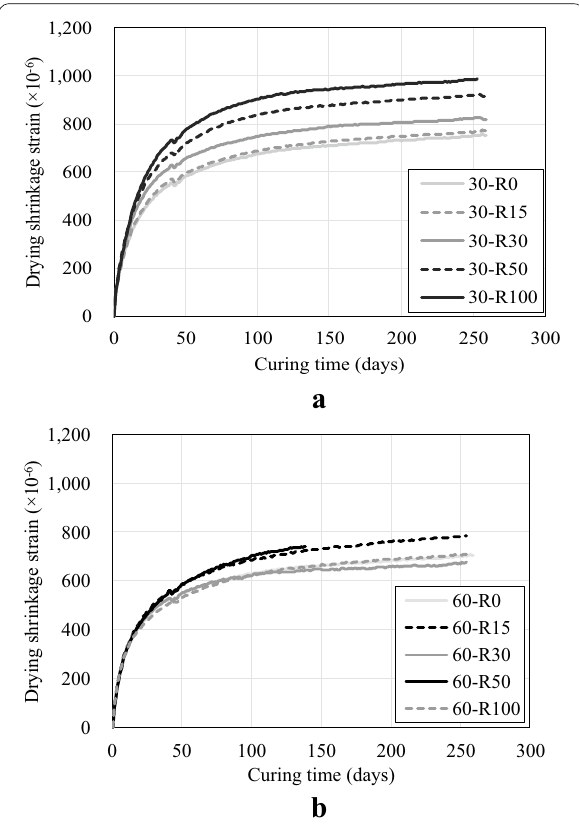
Fig. 5 Comparison of the compressive strength between the present study and previous experimental results for a NS concrete, and b HS